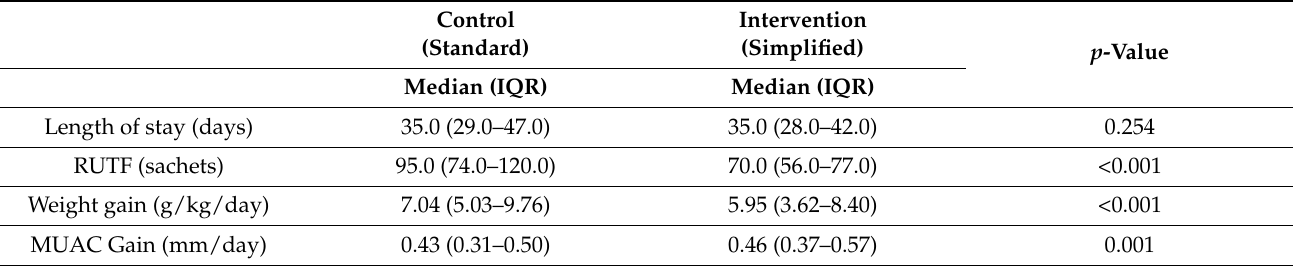
Table 5. Treatment duration, product consumption, and the anthropometric gain of cured